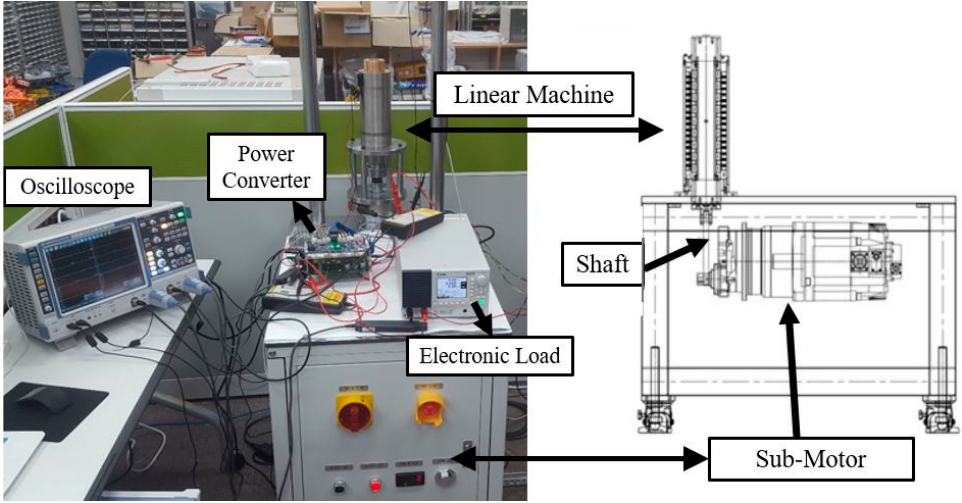
Figure 9. Experimental test setup.